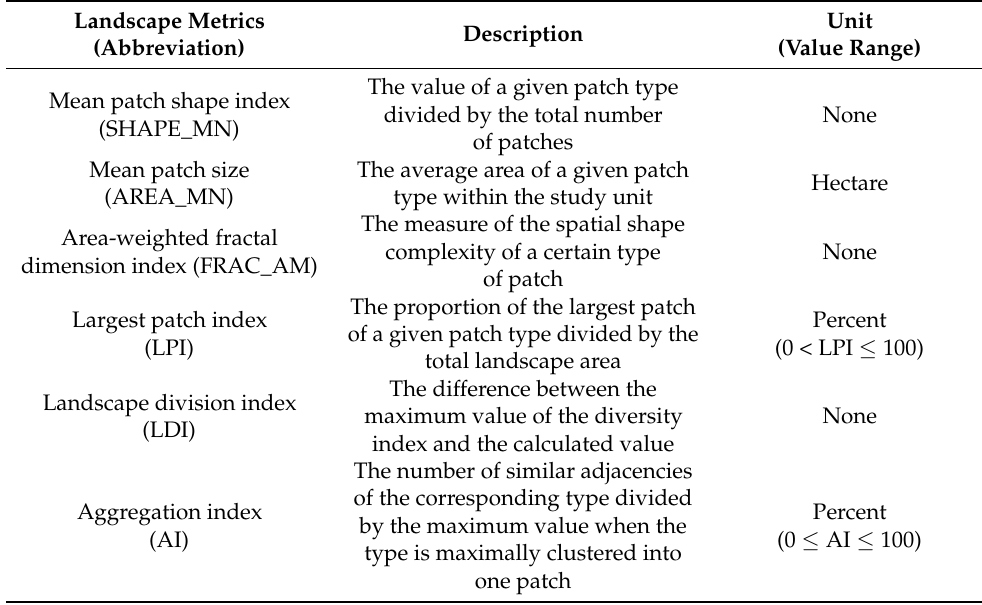
Table 1. The landscape metrics used to delineate the shape configuration of the land surface compo- nents (LSC) analyzed in this